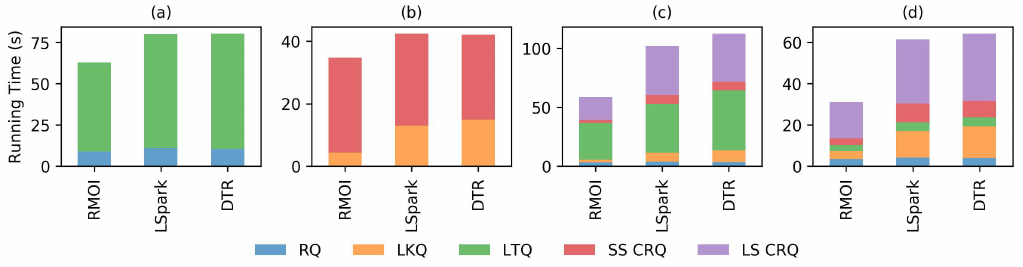
Figure 11. Stress testing for the RioBuses dataset with low resource availability on ( a ) 1st query set with 3 QTs, ( b ) 2nd query set with 3 QTs, ( c ) 3rd query set with 7 QTs, ( d ) 4th query set with 7 QTs, ( e ) 5th query set with 10 QTs, and ( f ) 6th query set with 10 QTs.